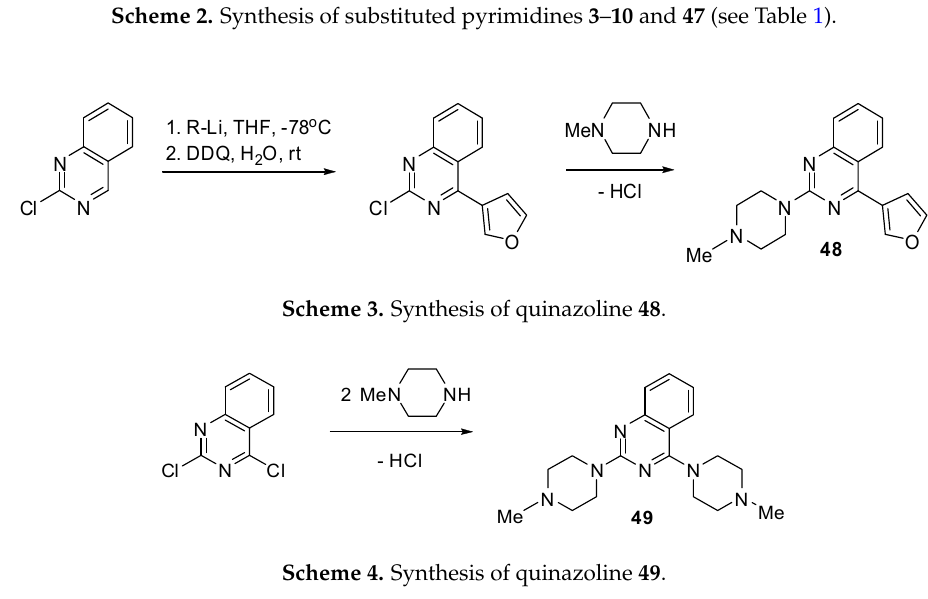
Scheme 5. Synthesis of quinazoline 50 .